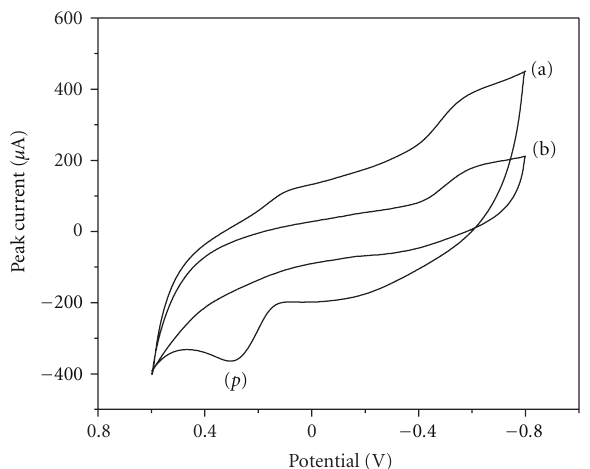
Figure 3: Cyclic voltammograms obtained at bare CPE (b) and PVP/CPE (a) surfaces using 1 . 0 × 10 − 5 molL − 1 morin solution in 0.05mol L − 1 PBS (pH 6.5).